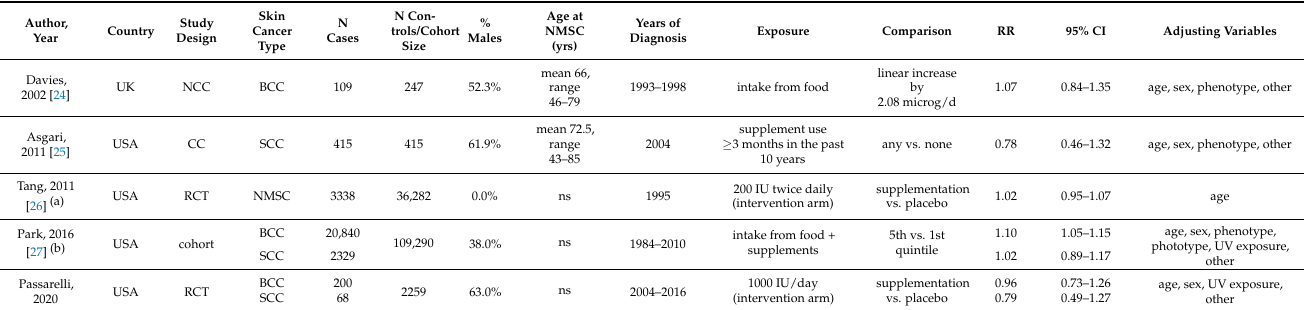
Table 3. Main characteristics of the studies reporting on the association between vitamin D intake (from foods, supplements, or both) and the risk of non-melanoma skin cancer.